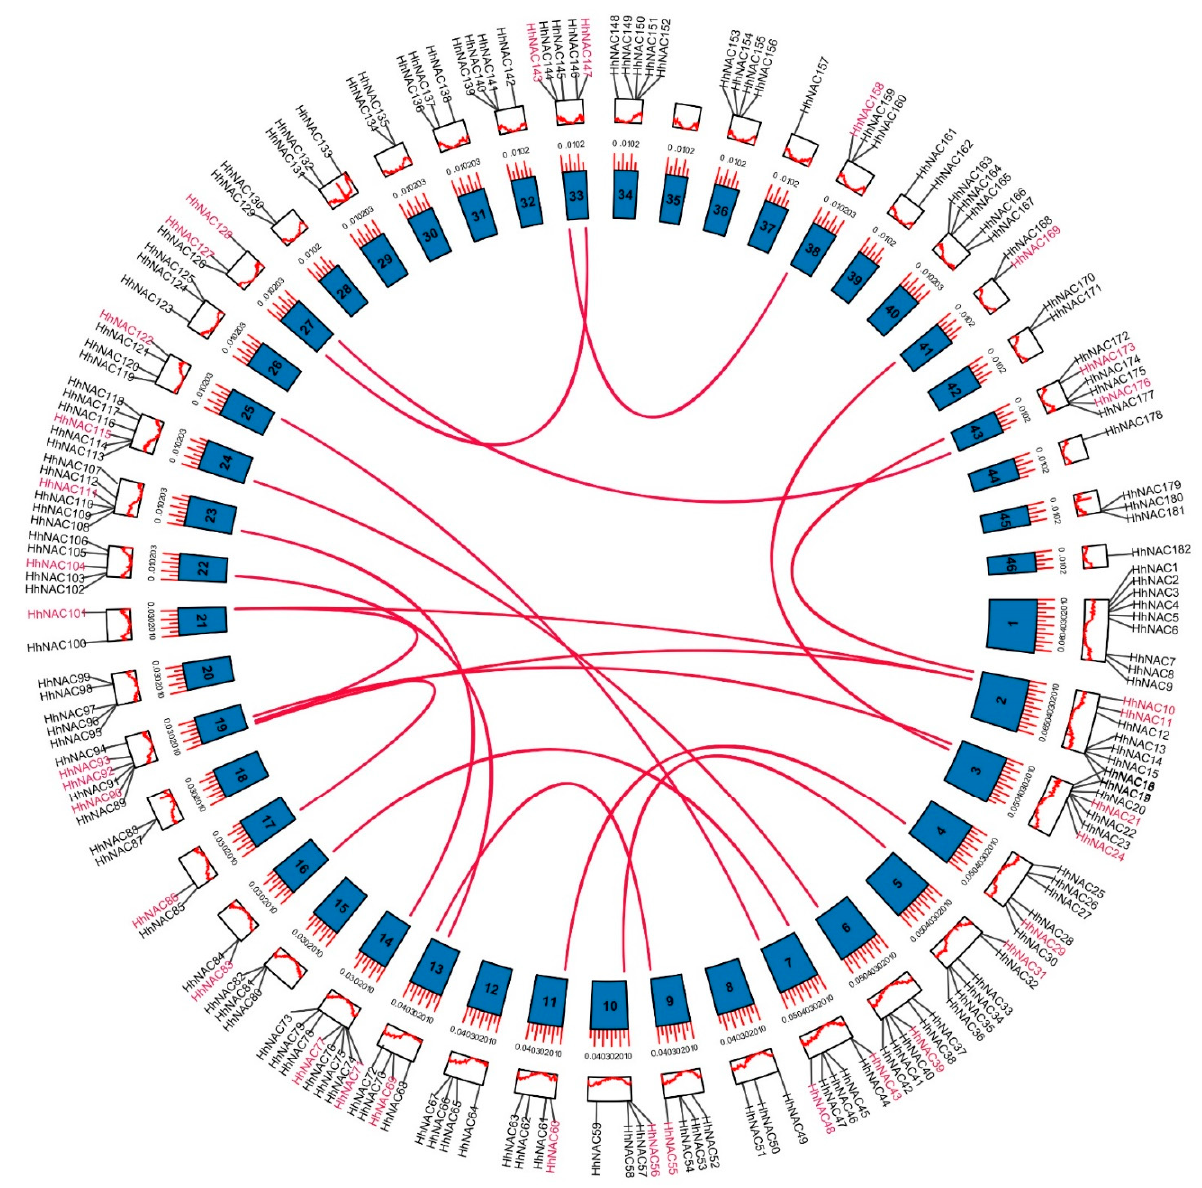
Figure 3. Chromosome locations and collinear relationships of HhNAC genes. The inner circle represents different chromosomes. The red lines in the inner circle indicate genes exhibiting col- linearity.